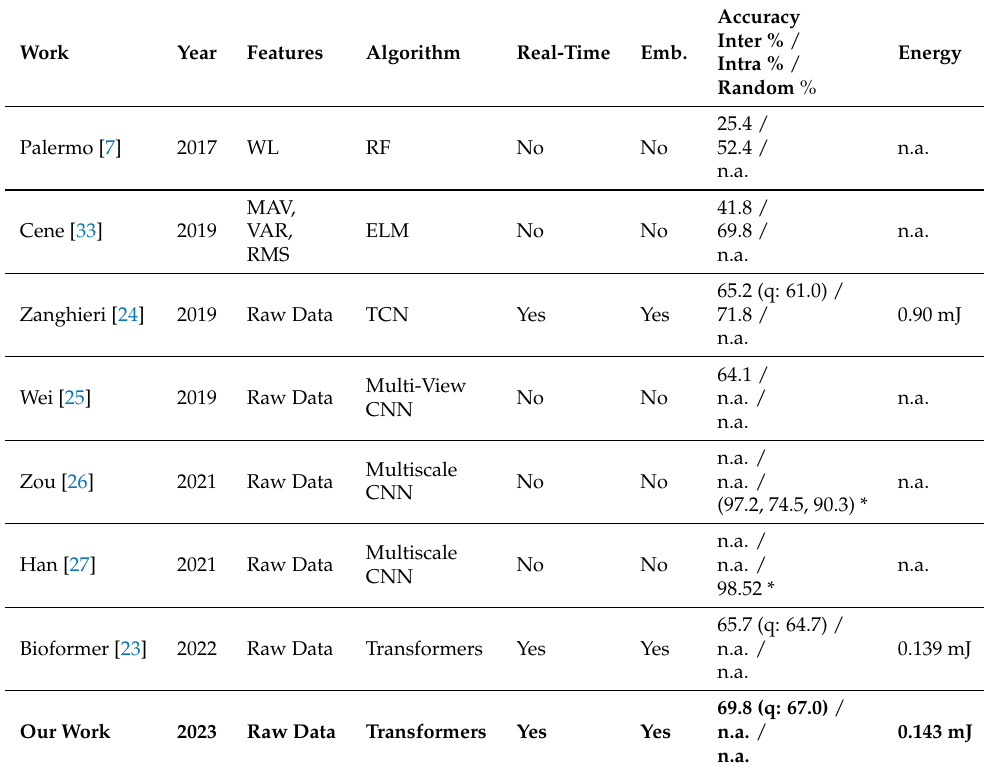
Table 1. Previous works tested on Ninapro DB6 dataset [7]. Accuracy results preceded by “q:” refer to models using a int8-quantized data